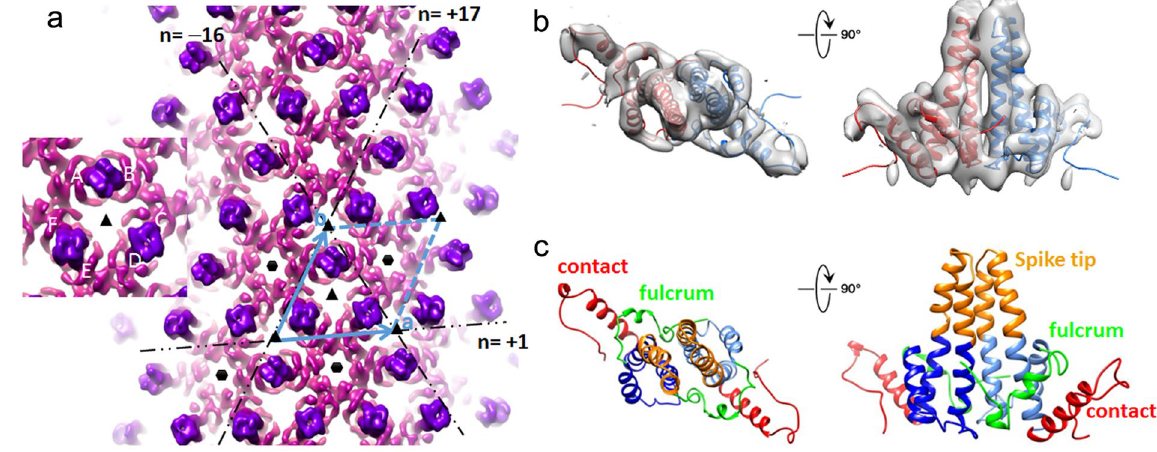
Figure 2. EM density map of HBc tubular ensemble and structural model of HBc dimer in tubular ensemble. ( a ) EM density map of reconstructed HBc tubular ensemble with helical lattice indexes and symmetry elements (quasi 3- and 6-fold axes) marked; the unit cell containing trimer of dimers is framed; the inset is an enlarged version of the trimer of dimer in the unit cell, composed of AB, CD, and EF dimers. ( b ) EM map of segmented AB dimer (transparent grey) with structural model (coloured ribbon) fitted in top (left) and side (right) views. ( c ) Structural model of the AB dimer built by MDFF in top (left) and side (right) views; the structural elements are colour-coded and the structural elements critical for HBc assembly are marked according to the scheme of Packianathan et al . 20 .